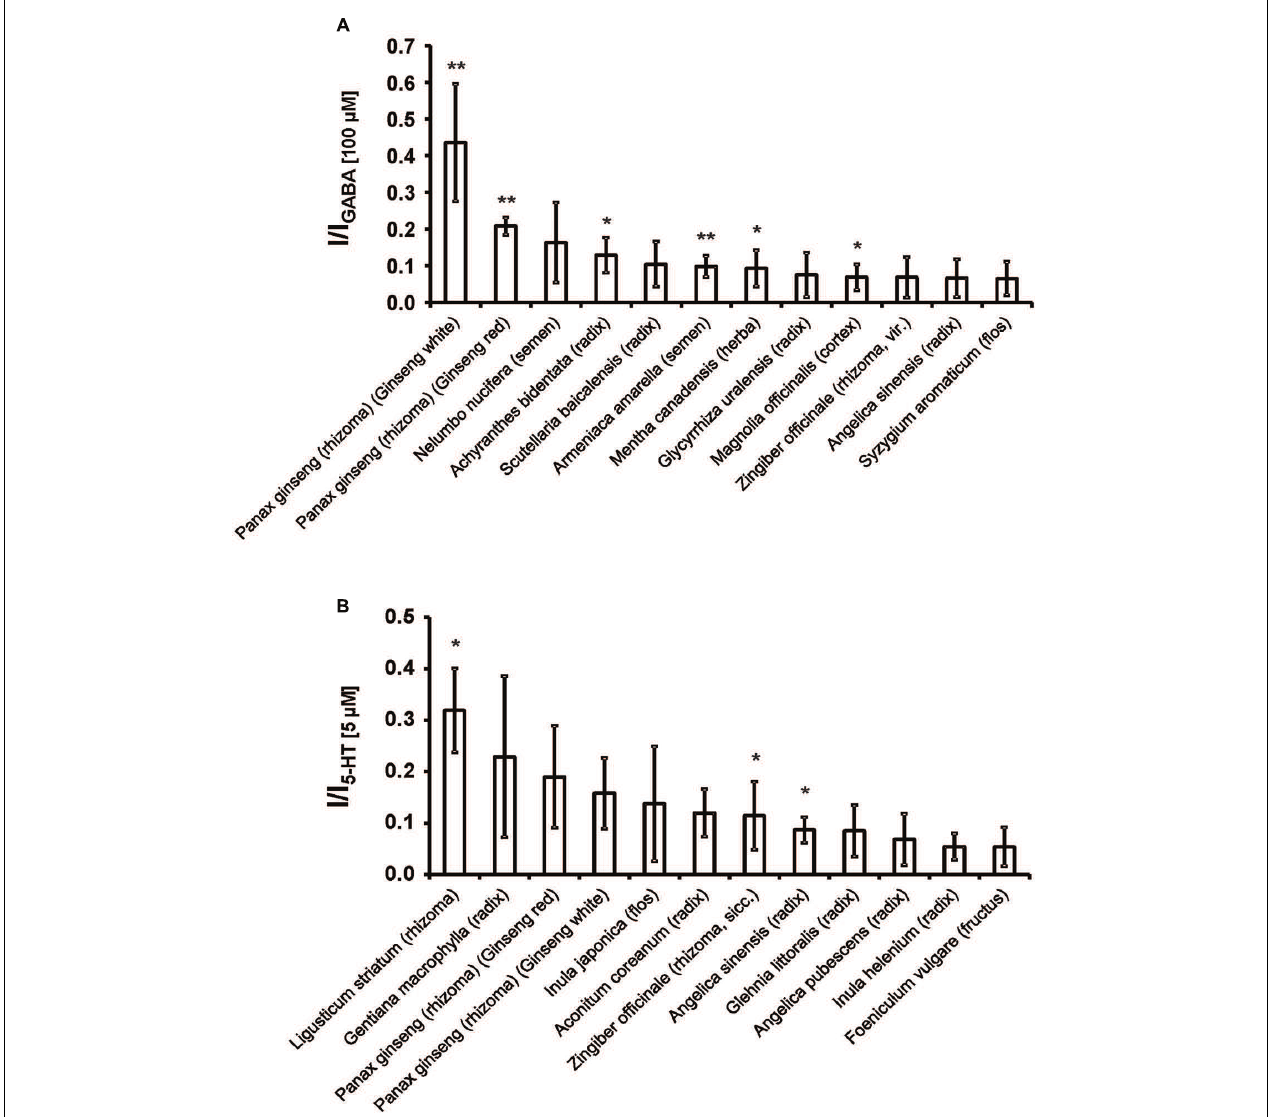
FIGURE 1 | The strongest 12 direct activating tinctures for the 5-HT 3A (A) and GABA A receptors (B). The 121 tinctures were made from Kampo remedies via ethanol extraction (see section Tinctures and substances). A 1:1,000-dilution was applied to the oocytes and compared with agonist induced currents (5 µ M 5-HT, 100 µ M GABA). Error bars represent the SEM. Statistical significance was calculated based on the current evoked by ethanol (0.1 Vol.-%; ∗ p < 0.05, ∗∗ p < 0.005; n =